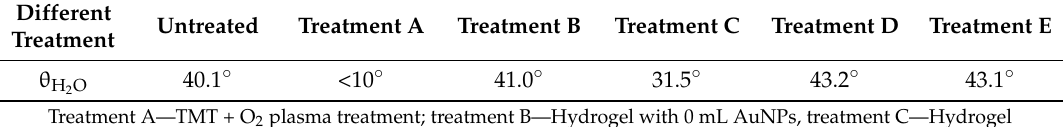
Table 2. Water contact angles of electrode substrate after different treatments.